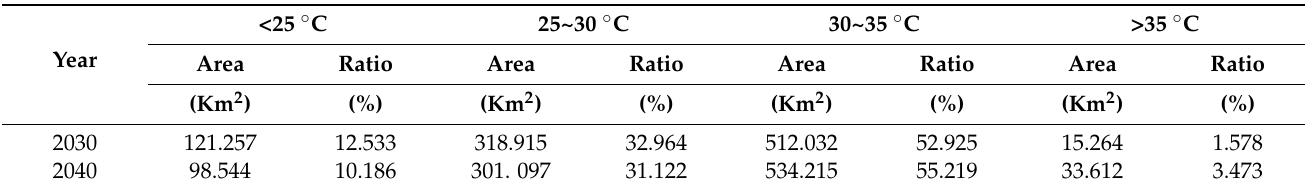
Figure 6. Simulation of LST for 2030 and 2040. Table 7. Statistical description of LST in main urban areas in 2030 and 2040.